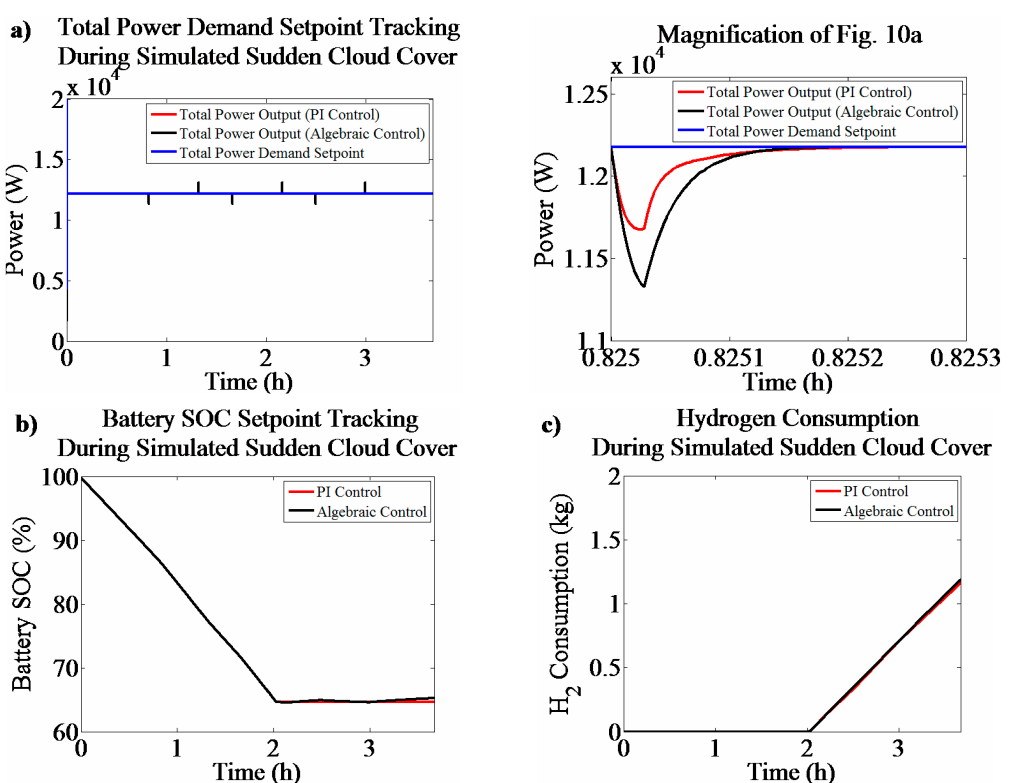
Figure 9. Idealized solar irradiance profile used to simulate how sudden changes in cloud cover affect bus operation with a roof-installed PV array. Solar irradiance is instantaneously decreased from 1000 W/m 2 to 200 W/m 2 three times for 30-min intervals during the 3:40 simulation of bus operation.